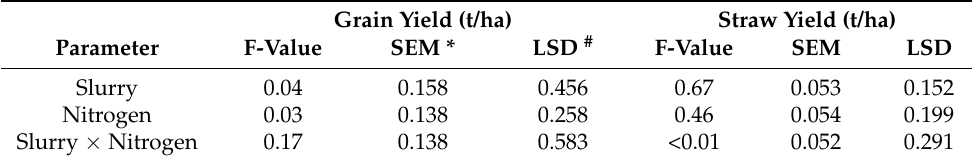
Figure 1. Grain yield from rate of nitrogen, timing and application of slurry (t/ha). Error bars represent standard error of the mean (SEM). Different letters denote statistical differences between treatments determined through Fisher’s protected least significant difference (LSD) (0.05). Grain yields are shown at 15% moisture content (M.C). Table 5. REML analysis of 2016/17 spring barley grain and straw yields (t/ha).